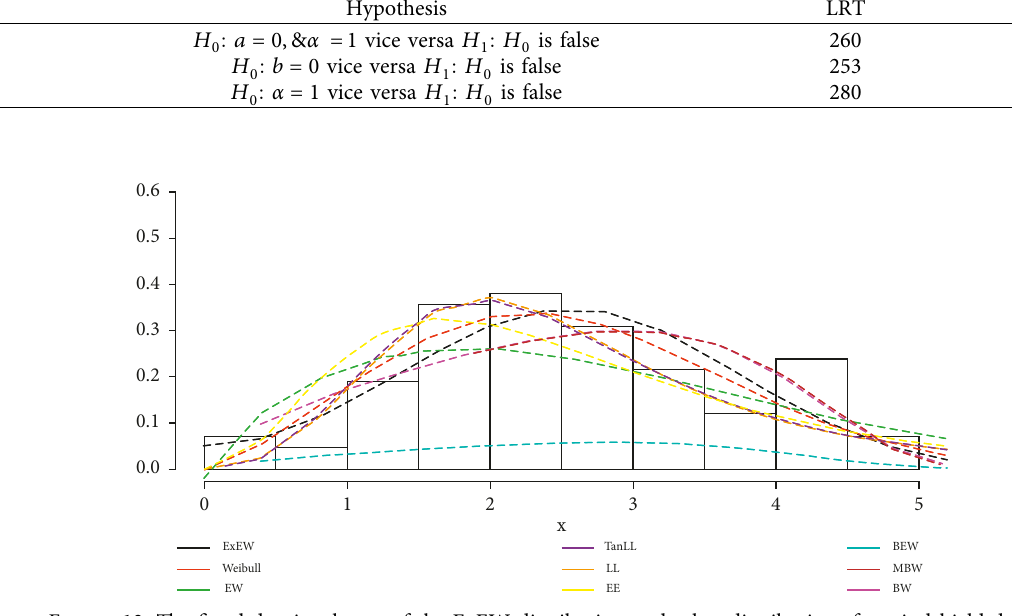
Figure 12: The fitted density shapes of the ExEW distribution and other distributions for windshield data.